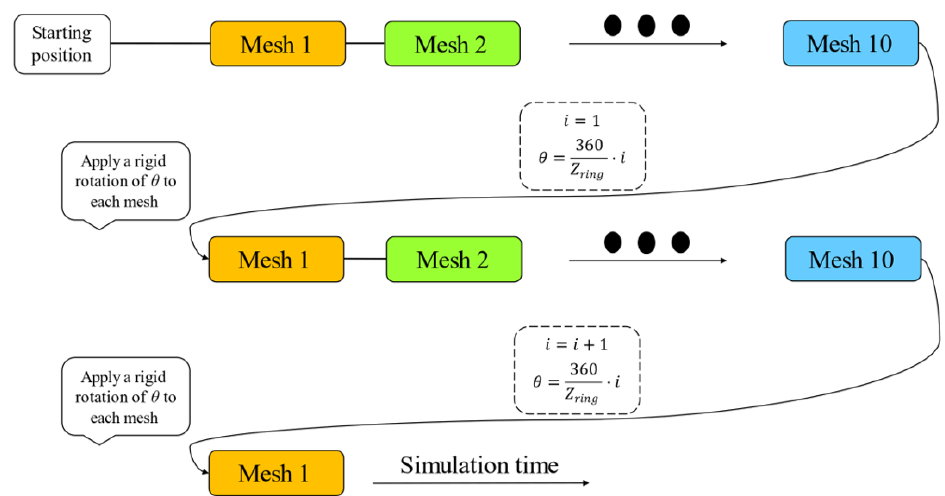
Figure 4. Flowchart of the implemented mesh-handling strategy.